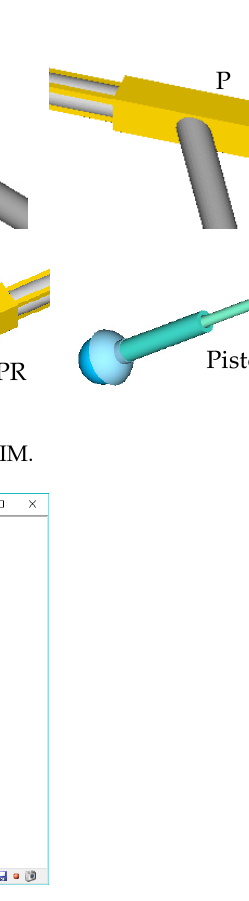
Figure 5. Position of a point in spherical coordinates.